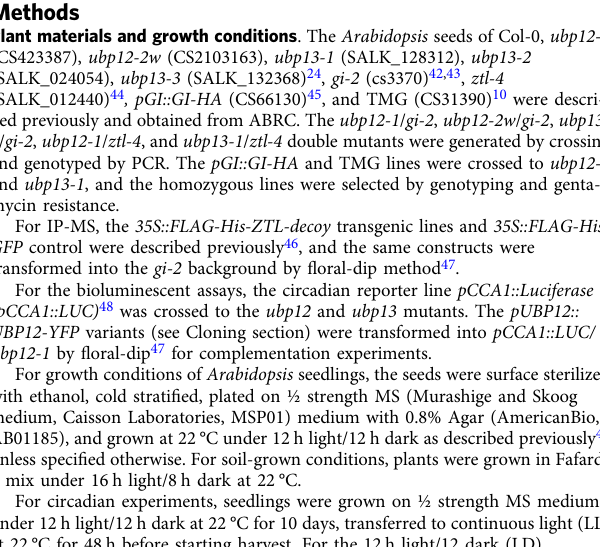
greater than the average of the ubp12-1 mutant plus one standard deviation. The source data are provided as a Source Data fi